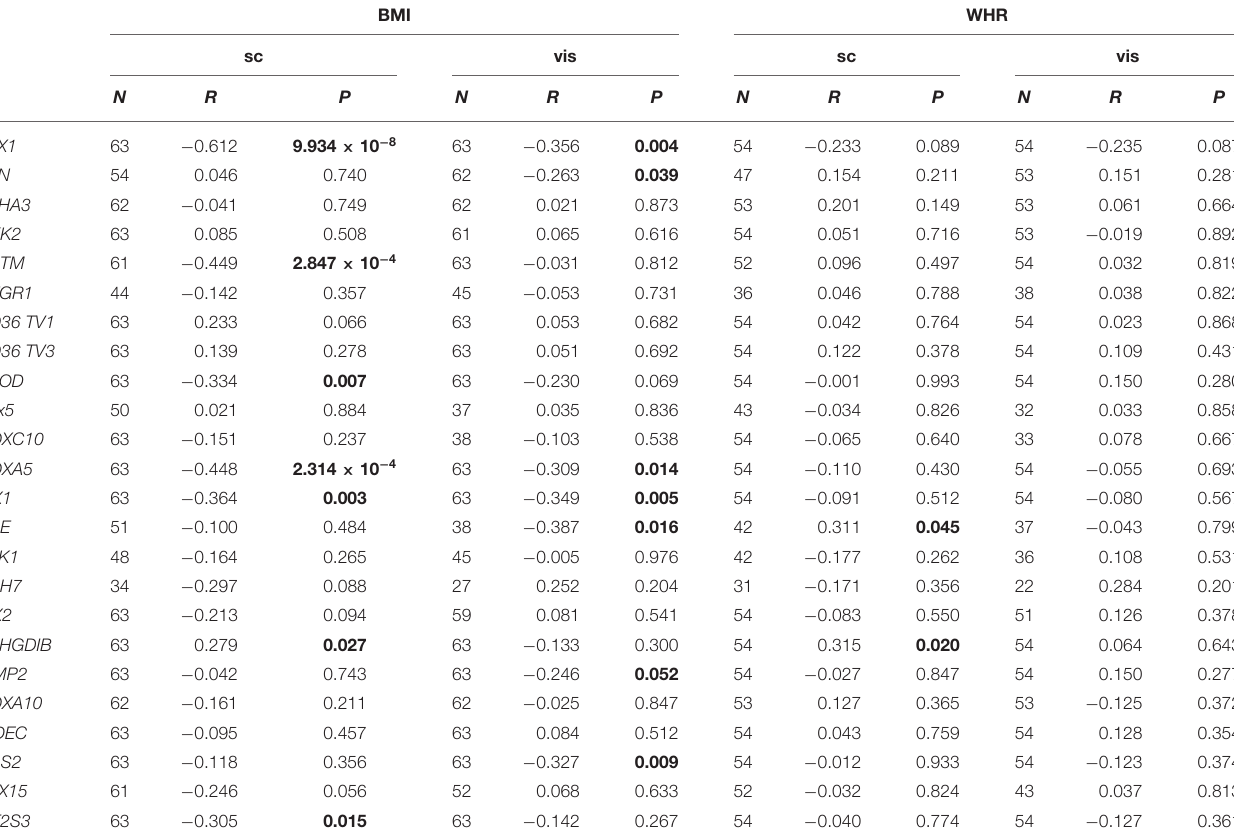
TABLE 2 | Correlation of BMI and WHR with the mRNA expression in human adipose